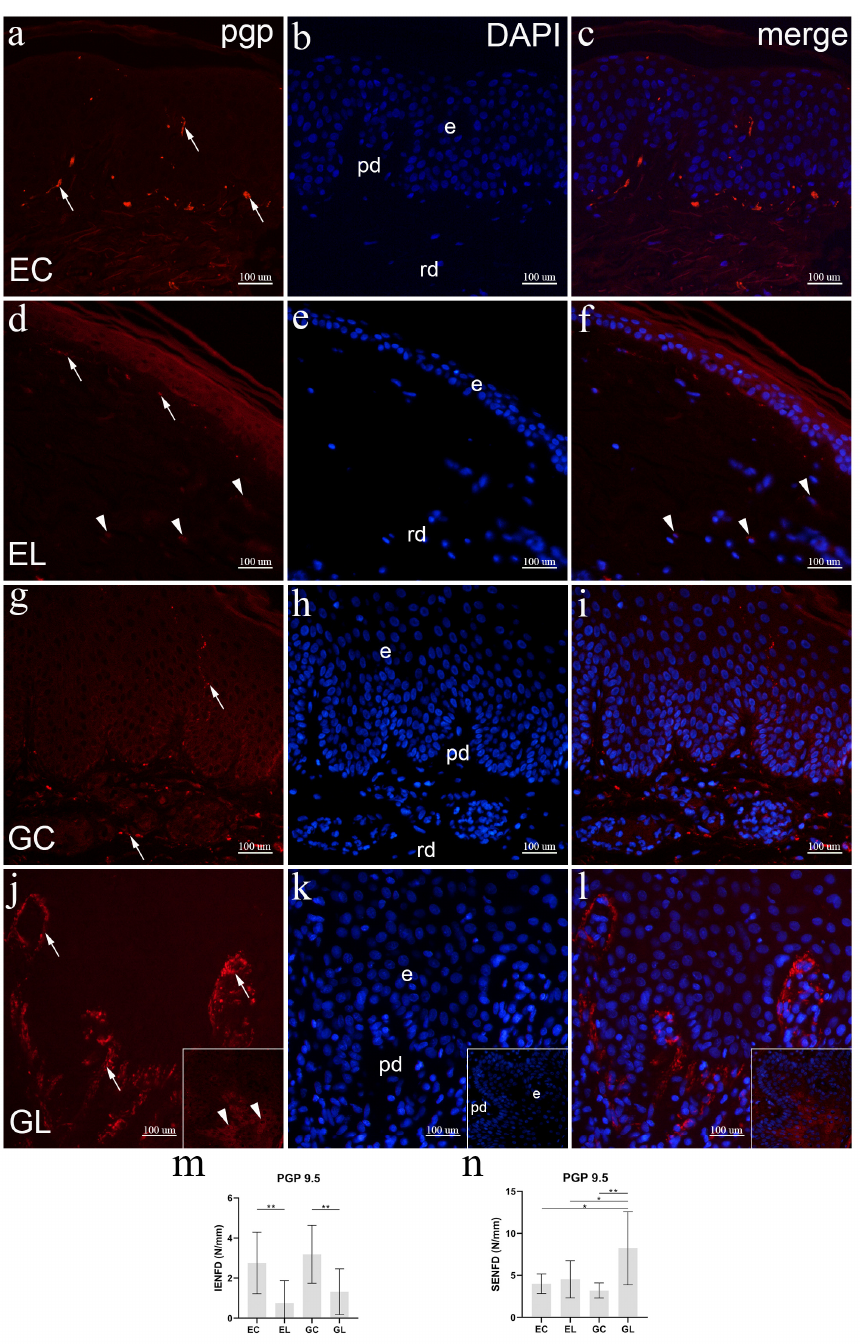
Figure 6. Expression of PGP 9.5 in normal skin and lichen sclerosus skin samples. The epidermis